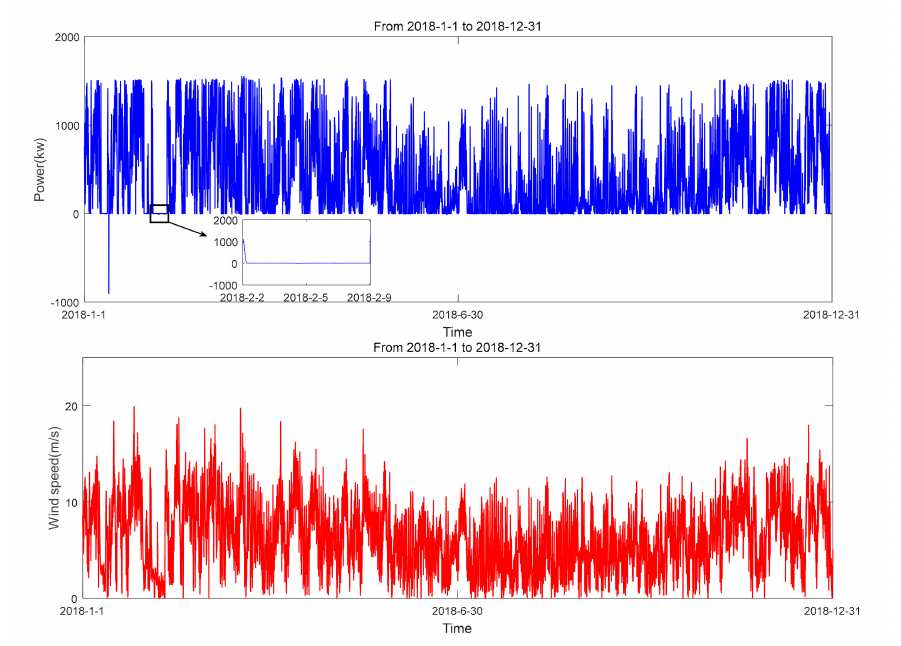
Figure 2. Wind speed and power curve of a wind turbine in